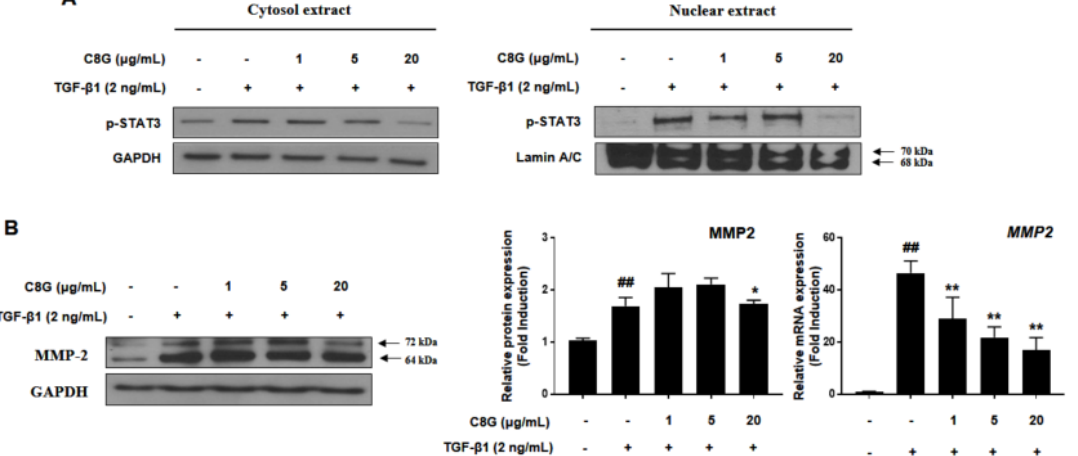
Figure 5. C8G inhibited nuclear translocation of p ‐ STAT3. ( A ) The expression levels of p ‐ STAT3 were analyzed from cytosolic and nuclear protein fraction. Lamin A / C was used as a cytosolic and nuclear loading control. ( B ) The protein and mRNA level of MMP2 was measured by qPCR and western blot analysis. Each experiment was conducted under the condition of present ( + ) or absence ( − ) of C8G and TGF- β 1 and repeated three times and values represent mean ± SD. ## p < 0.01 compared with control, * p < 0.05, ** p < 0.01, compared with TGF- β 1 treatment cells.